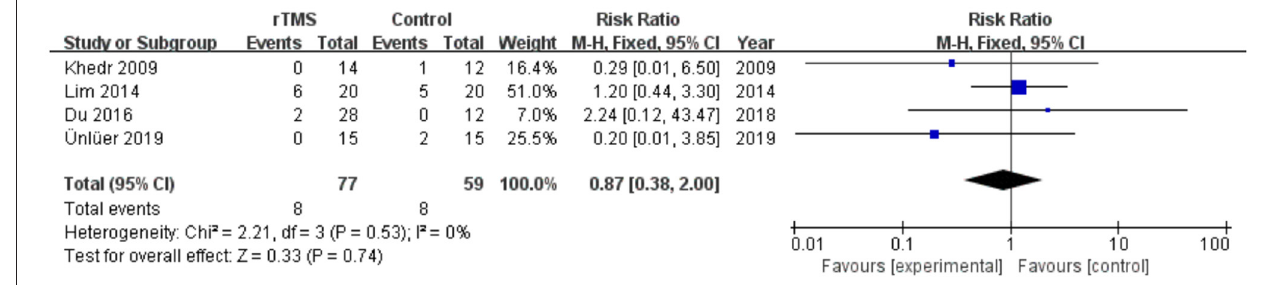
FIGURE 11 | Forest plot for subgroup analysis for Dropout Rate.